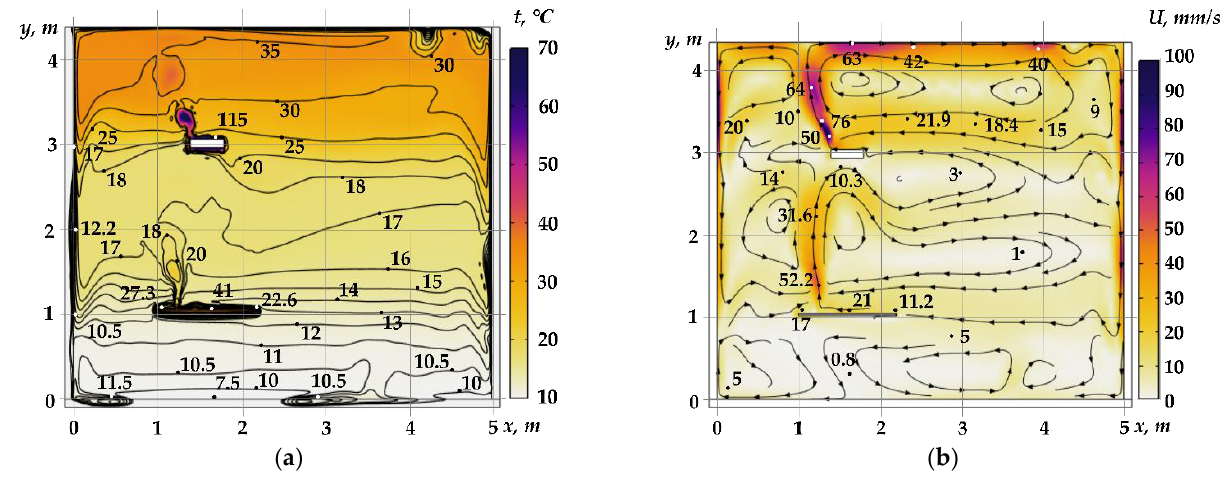
Figure 12. Temperature fields ( a ) and streamlines ( b ) for the area with the panel ( X Tb = 1.6 m, Y Tb = 1.055 m) in the GIH operation zone (τ = 60 min).